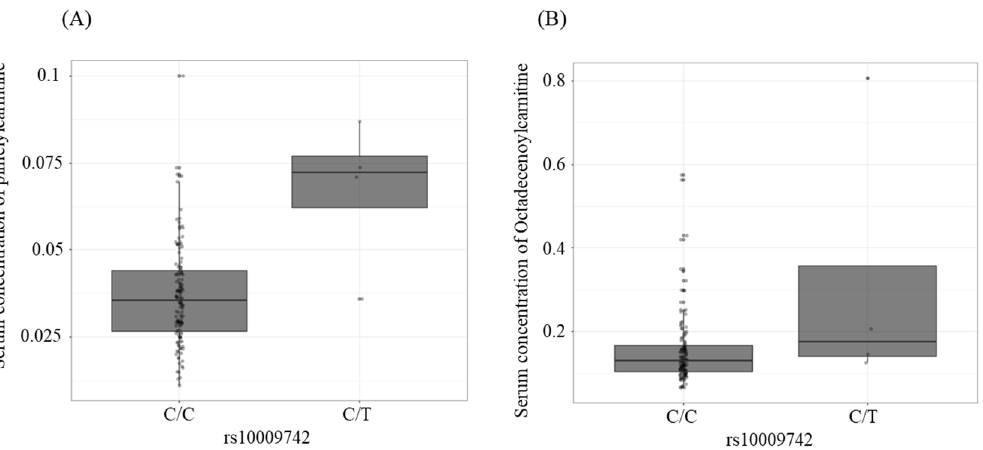
Figure 2. Associations between rs10009742 in the MARCHF1 gene and serum metabolite concentra- tions using a linear regression model from GMIA. ( A ) Pimelylcarnitine and ( B ) octadecenoylcarnitine (C: reference allele; T: the effect allele of rs10009742). GMIA, genome–metabolomics integrative analysis; MARCHF1 , membrane-associated ring-CH-type finger